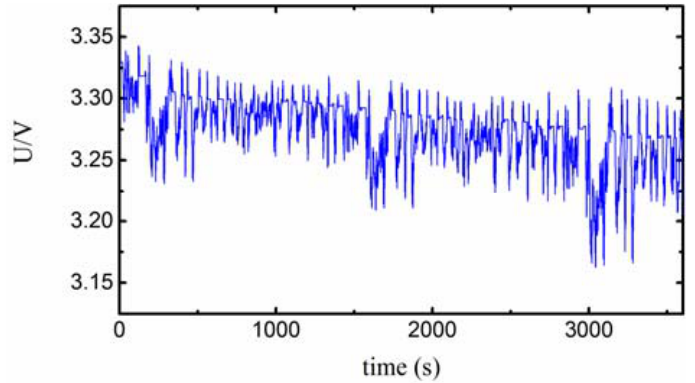
Figure 9. Terminal voltage of battery with abrupt ‐ type fault.